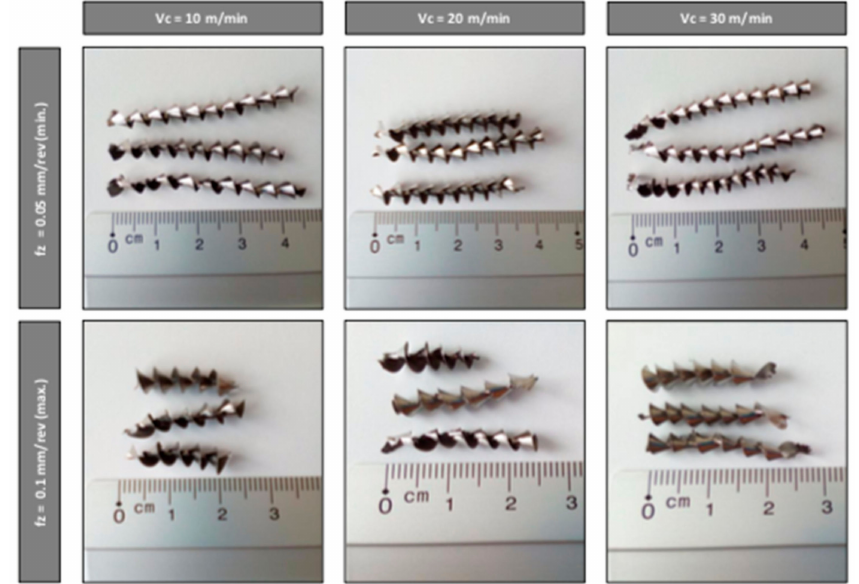
Figure 7. E ff ect of cutting speed and feed rate on chip morphology in drilling of WAAM specimen.